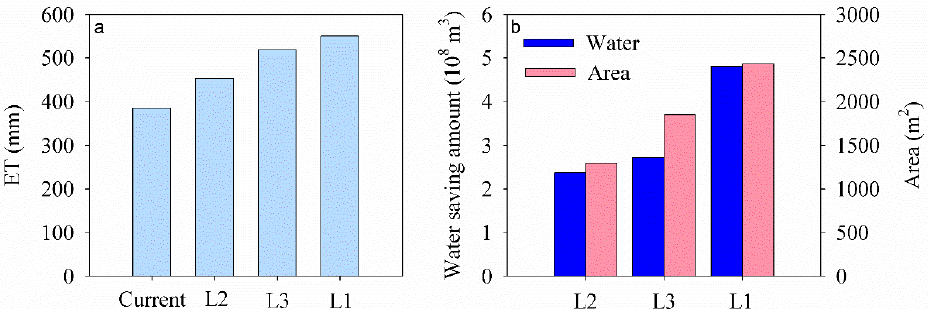
Figure 9. Impact of consolidation of fragmented plots on Hotan irrigated agriculture. ( a ) Effects of different land consolidation on the ET of Hotan Oasis; ( b ) the water saving amount of irrigation and the scale change of Hotan Oasis after land consolidation.